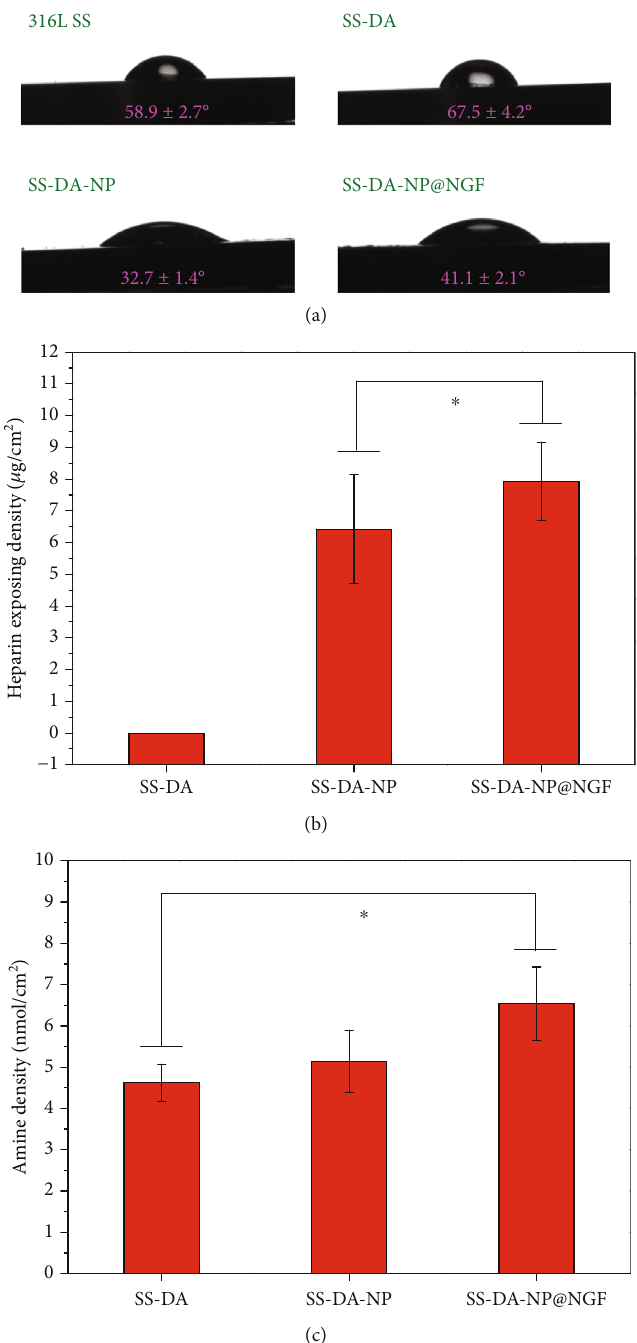
Figure 3: (a) Water contact angle of di ff erent sample surfaces. Quantitative characterization result of (b) heparin and (c) amine group exposing density ( mean ± SD , N = 6 , ∗ p < 0 : 05 indicates signi fi cant di ff